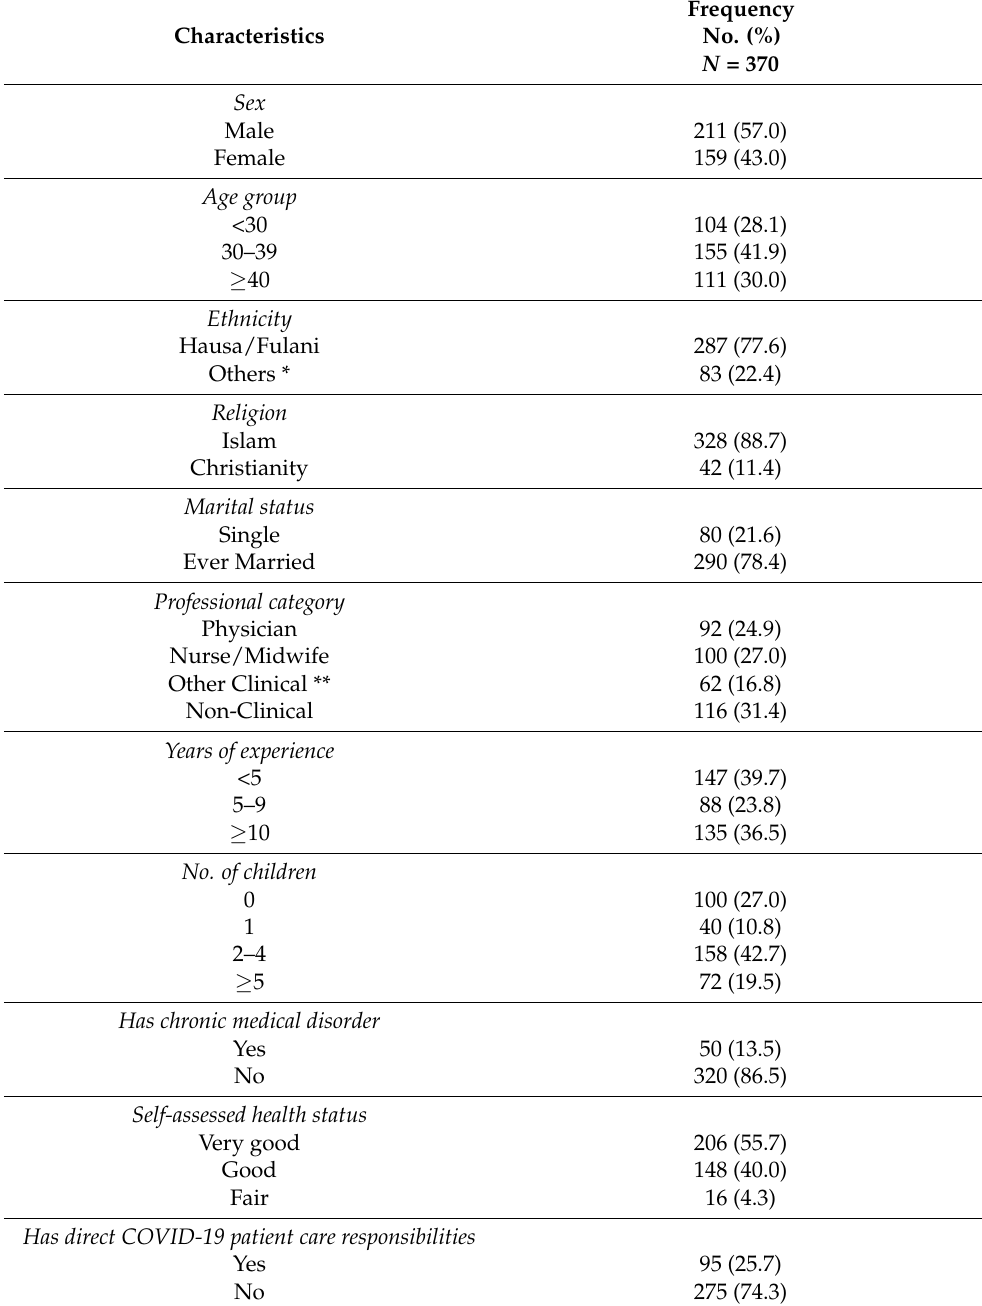
Table 1. Characteristics of health care workers, Kano, Nigeria,